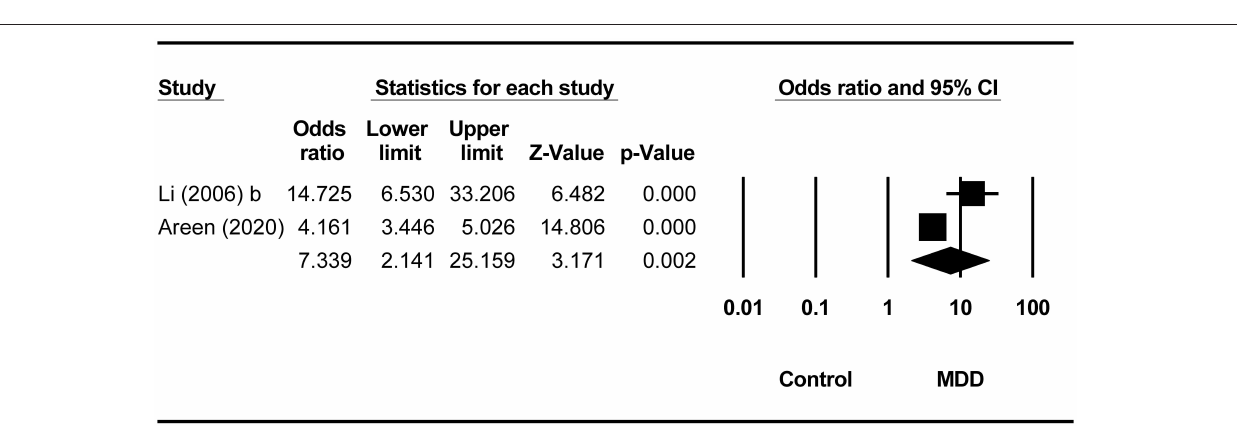
FIGURE 4 | Comparison of 1-year prevalence of suicide attempts between the MDD and non-MDD